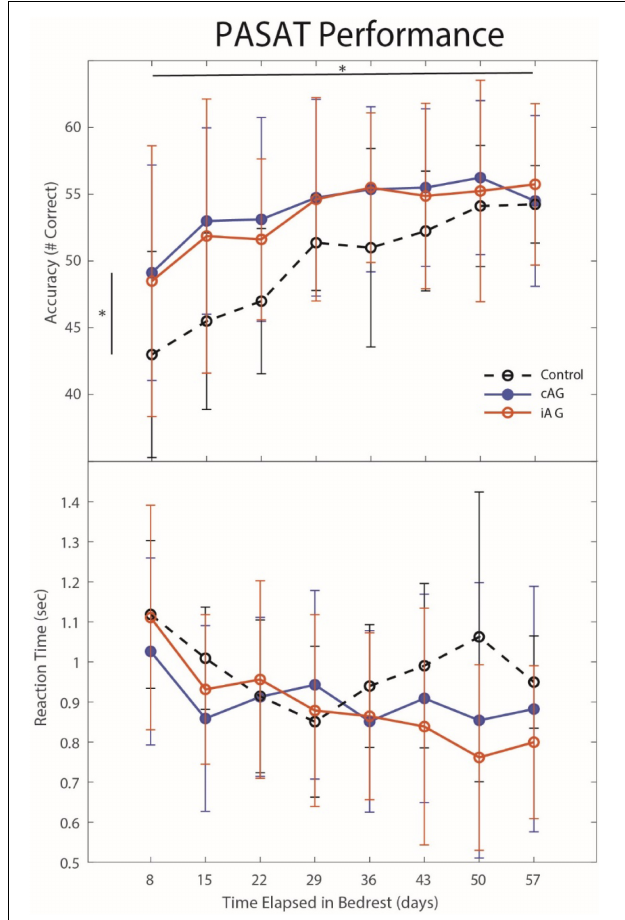
FIGURE 4 | Paced Auditory Serial Addition Task (PASAT) changes during HDBR. PASAT accuracy results indicate that both AG groups performed with higher accuracy throughout HDBR ( p = 0.015) than the control group, although all groups increased accuracy through HDBR ( p = 0.0001). There was also a significant group by time interaction ( p = 0.01) for PASAT reaction times. Significant differences are noted by